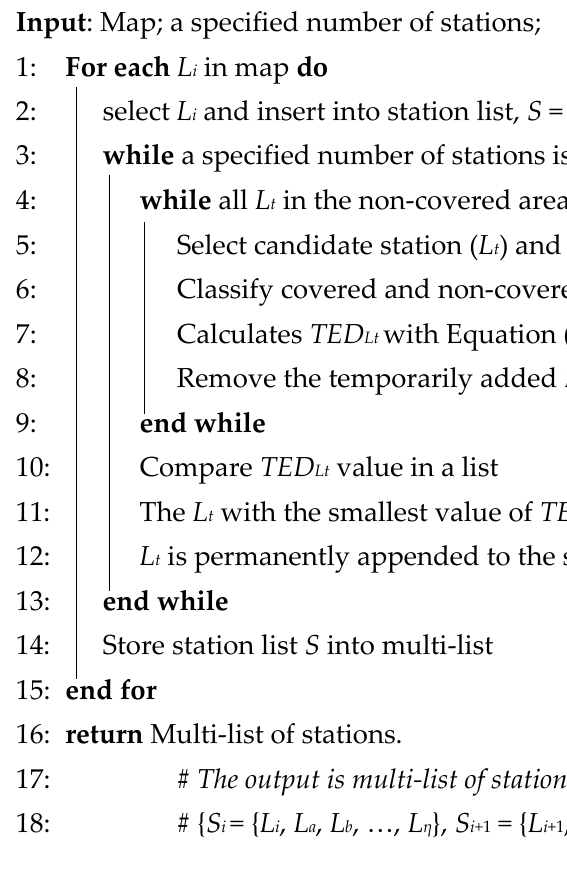
Algorithm 2. Euclidean Distance + Fixed Surrounding Sphere (ED + FSS)